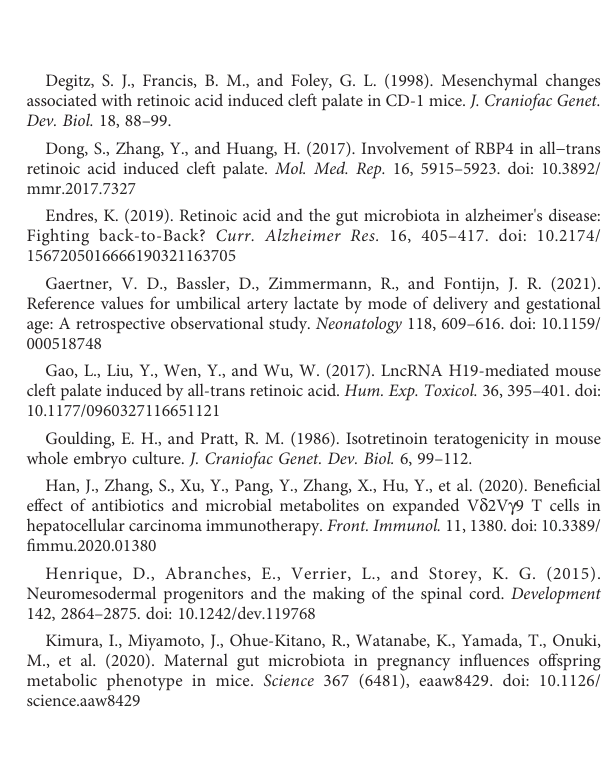
SUPPLEMENTARY FIGURE 1 The morphology of palatal shelves and tongue at E16.5 embryos. (A) The morphology of palatal shelves and tongues in control group. (B) The morphology of palatal shelves and tongues in RA group. PS, palatal shelf; T, tongue; NS, nasal septum; magni fi cation ×40, scale bar 200 m